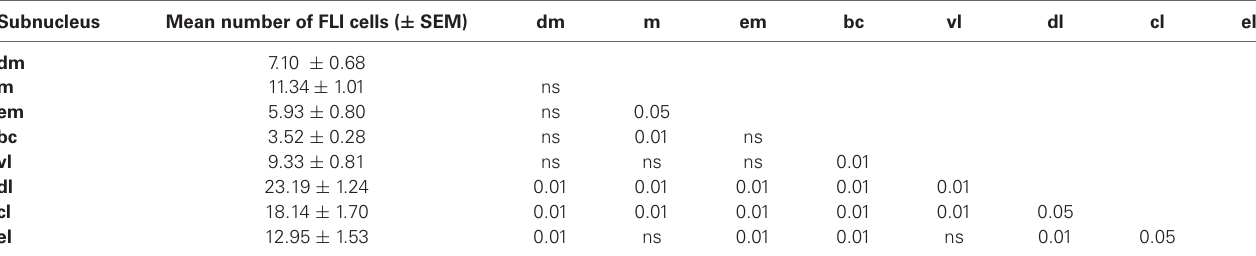
Table 1 | Mean counts of FG-labeled cells in each subnucleus (collapsed across stimulus groups) . Subnucleus Mean number of FLI cells ( ± SEM) dm m em bc vl dl cl